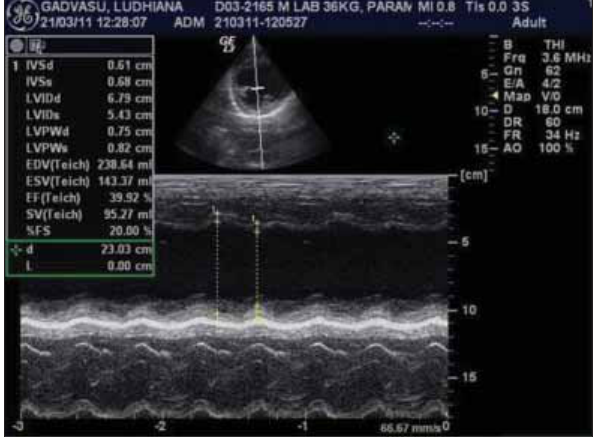
Figure-6: Lateral view radiograph of animal affected with pericardial effusion.